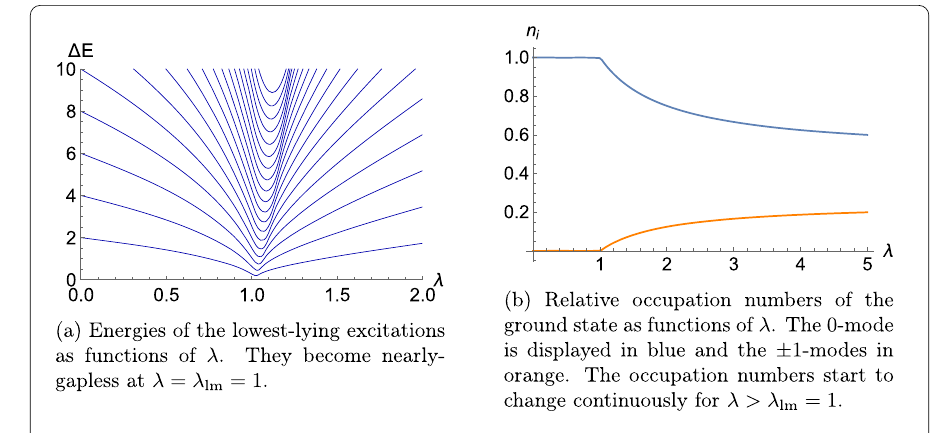
Figure 11 Numerical analysis of the periodic system for N = 1000. The Hamiltonian (58) is truncated to the 0- and ± 1-modes. At λ lm = 1, a gapless mode appears in the spectrum and the ground state undergoes a second-order phase